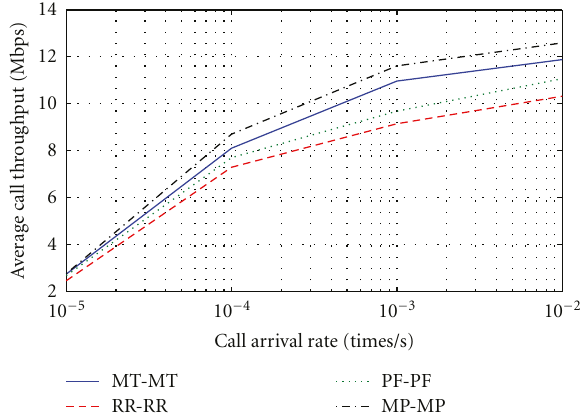
Figure 4: Average cell throughput in the whole cell with various call arrival